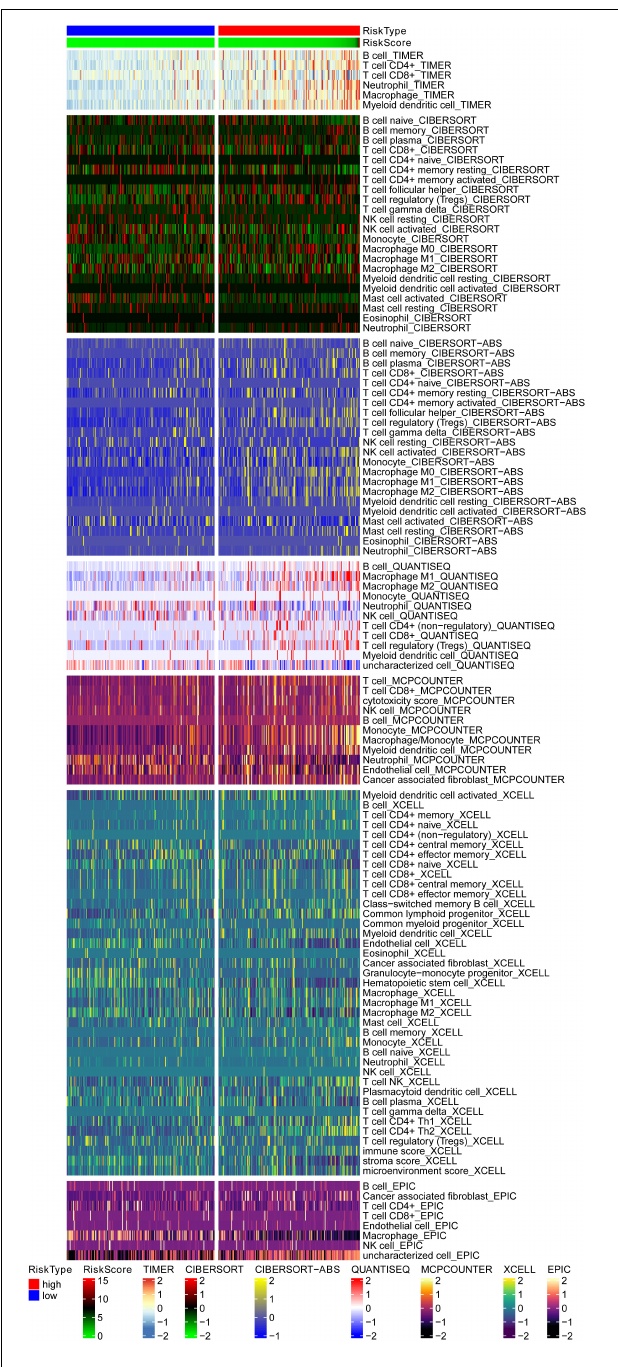
FIGURE 11 | The heatmap of immune responses based on different algorithms among the high- and low-risk group, and the results demonstrated that most immune cells showed a trend of high expression in the high-risk group when compared with the low-risk group. TIMER, tumor immune estimation